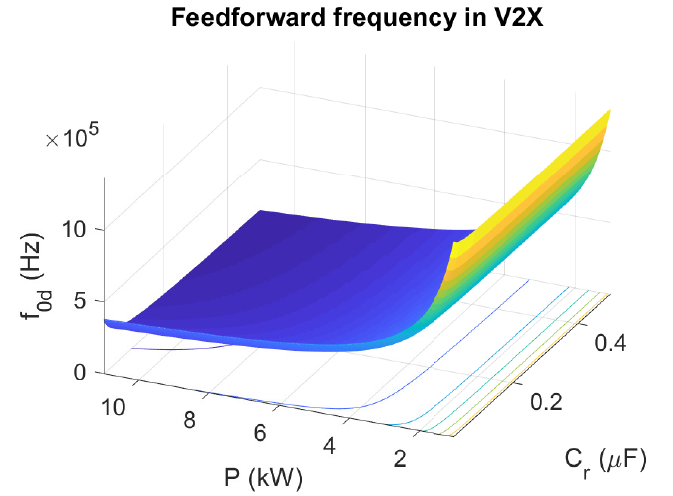
Figure 11. V2X feedforward frequency in function of C r .